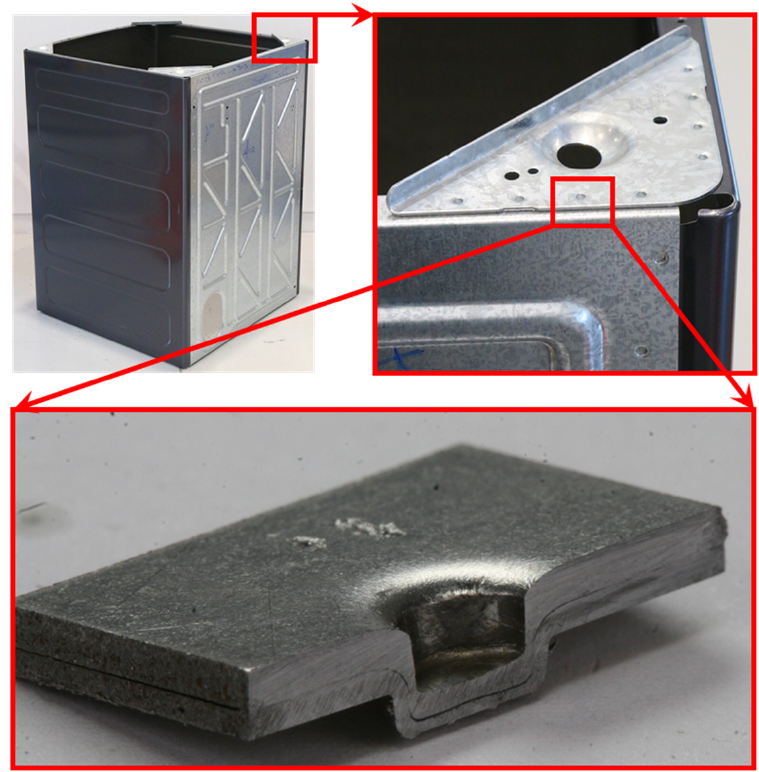
Figure 1. Application of clinching in a washing machine frame.